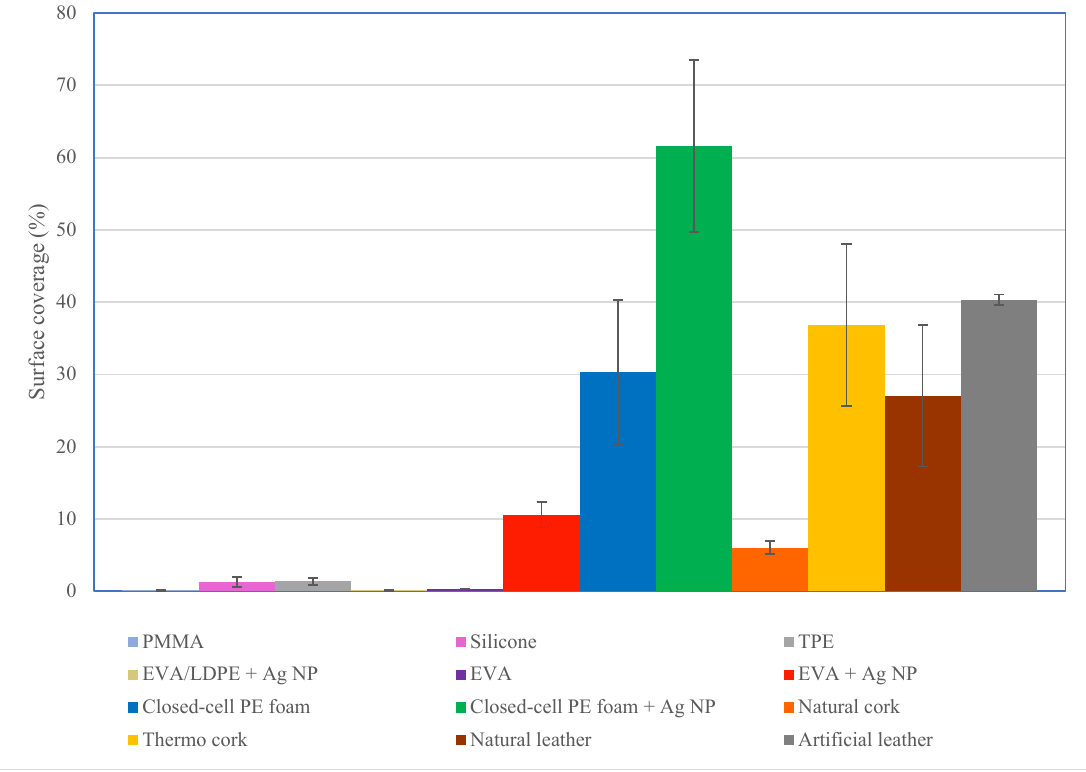
Figure 5. Surface coverage for different orthotic and prosthetic materials based on the evaluation of SEM micrographs. On the first four surfaces, S. epidermidis is adhered, whereas, on the rest of the surfaces, S. aureus is adhered.